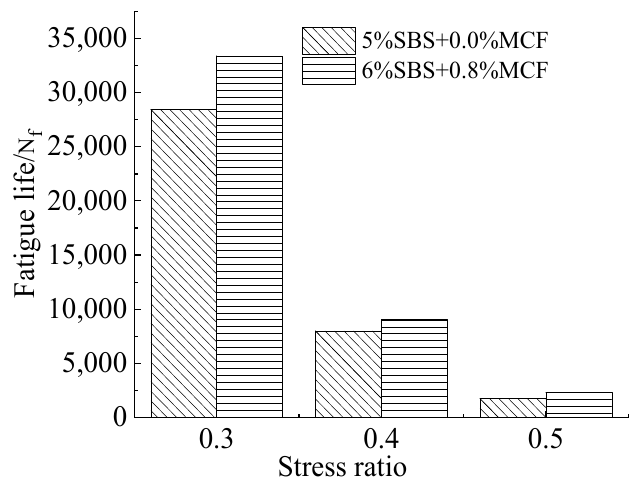
Figure 8. Results of fatigue tests for different stress levels.